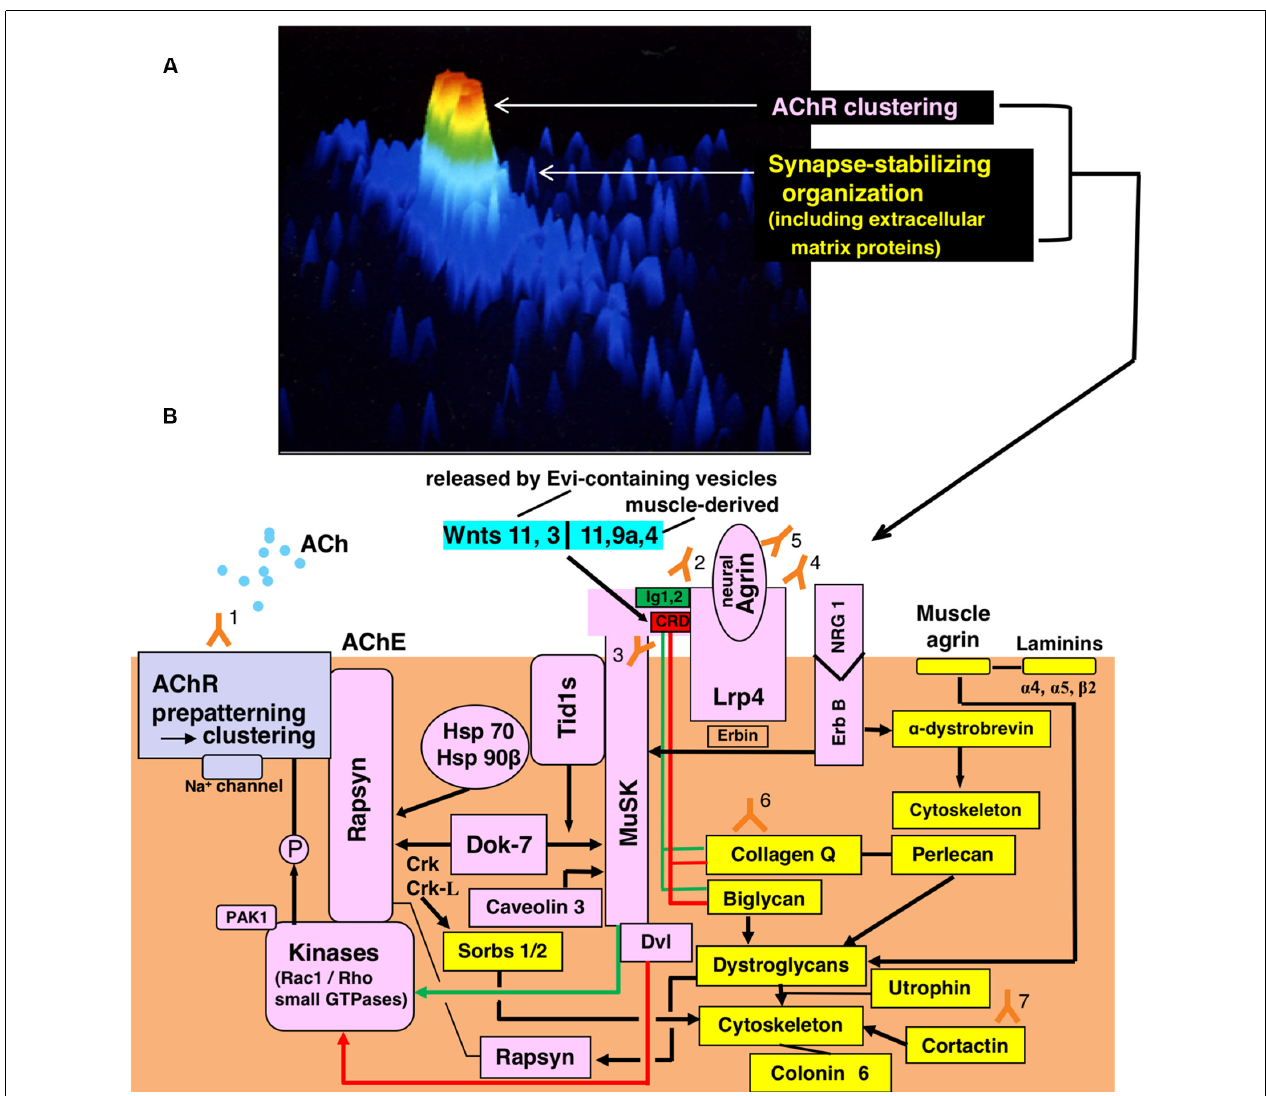
FIGURE 1 | Functional organization for synaptic transmission in neuromuscular junction (NMJ) and antibody-targets. (A) Presentation by staining of cultured rat myotube with fluorescence-labeled α -bungarotoxin and by the image analyzing using a laser cytometer, indicating acetylcholine receptor (AChR) cluster (red), a synaptic stabilizing organization including extracellular matrix proteins (gree and light blue). The image is constructed on ACAS 570 (Meridian Instruments Inc., Okemos, MI, USA) which provides a graded pseudocolor image on the computer display. (B) Schematic presentation of the post-synaptic structures. Y marks attached with numbers indicate the antibodies to recognize respective targets of the functional structures. Gray frame indicates the acetylcholine receptor (AChR) cluster formation. Pink frames indicate AChR clustering by way of two signaling pathways mediated via the muscle-specific tyrosine kinase (MuSK) 1/2 domains (green-limit in the pink MuSK ectodomain and green line with arrowhead) and MuSK cysteine-rich domain (CRD; red-limit in the pink MuSK ectodomain and red-line with arrowhead), the signals of which are mediated by Dishevelled (Dvl, adaptor protein). The low-density lipoprotein receptor-related protein 4 (Lrp4) is the receptor for agrin (partly for Wnts as described in the text). The small GTPases (shown in the pink frame of Kinases) effector PAK1 (p21-activated kinase 1) acts as a bridging molecule between the Wnt- and agrin-signaling pathways. From “inside” the muscle cell, MuSK is activated by Dok7 (downstream kinase); Dok7 recruits two adaptor protein, Crk and Crk-L (CT10 regulators of kinase) for rapsyn-anchored AChR cluster formation. The formed AChR clusters are anchored at the endplate membrane by rapsyn and immobilized by MuSK-linking heat-shock proteins (HSPs): tumorous imaginal disc 1 short form (Tid1s), HSP 70 and HSP 90 β . Tid1s is required for the MuSK-Dok7 signaling during the MuSK activation. The interaction of neuregulin 1 (NRG 1) with ErbB receptor (receptor tyrosine kinase of epidermal growth factor receptor family) increases the MuSK tyrosine phosphorylation ( via Erbin) and thereby modulates the MuSK-dependent AChR clustering. Caveolin 3 binds with the MuSK kinase domain and thereby driving AChR clustering. Yellow frames indicate the organizations for synaptic stability and maintenance. The synaptic stability of NMJ including AChR clusters (gray frame), MuSK (pink frame), Lrp4 (pink frame) and acetylcholinesterase (AChE) is modulated by extracellular matrix proteins (collagen Q, perlecan, biglycan, laminin-network including muscle agrin and laminins and dystroglycan) worked in cooperation with the cytoskeleton. The interaction of NRG 1 (neuregulin 1) with ErbB receptor (pink frames) contributes to the cytoskeletal organization through α -dystrobrevin phosphorylation on one hand (yellow frame) and the MuSK activation via Erbin on the other hand (pink frame). The downstream effector of Dok7-recruited Crk-L (Sorbs1/2) acts on the cytoskeleton for synaptic stability. Collagen Q-Perlecan and Biglycan act on Dystroglycans in cooperation with cytoskeleton for synaptic stability on one